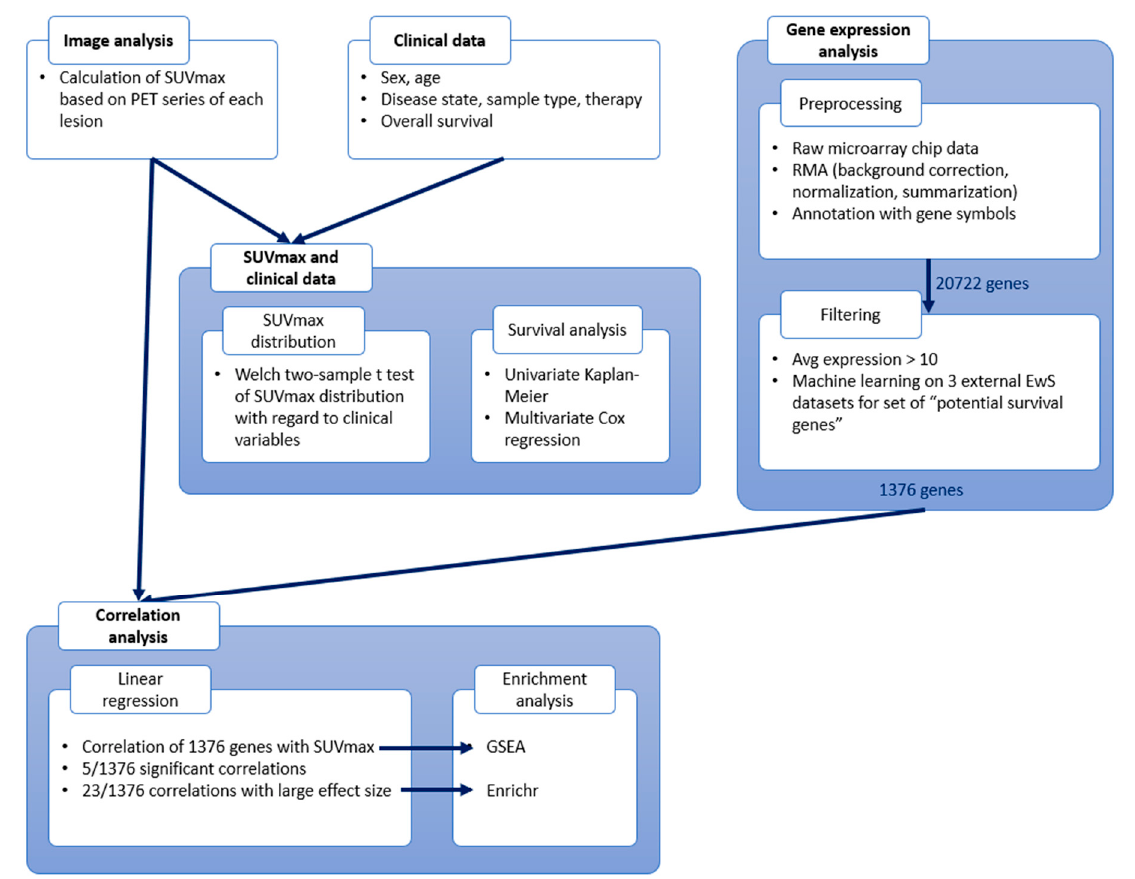
Figure 1. Workflow scheme. Overview of analysis steps. Positron emission tomography (PET) images are used to calculate maximal standardized uptake values (SUVmax). SUVmax distribution is analyzed with regard to clinical data, and a survival analysis is performed. Gene expression data is preprocessed and filtered, and afterwards correlated with SUVmax. The results of the correlation analysis are further annotated using enrichment